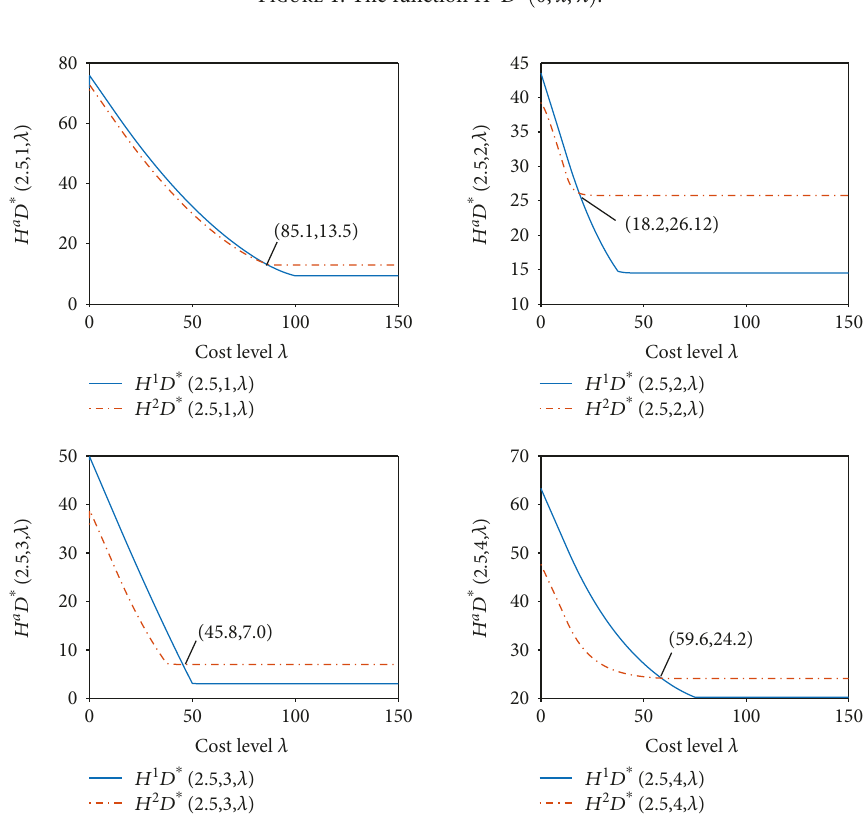
Figure 2: The function H a D ∗ 2 5, x , λ